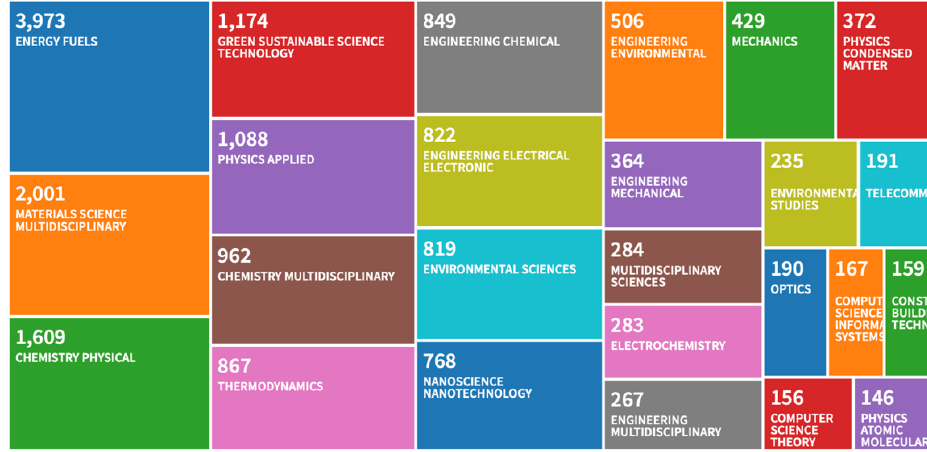
Figure 9. Publications according to WOS research categories for solar energy research in 2019–